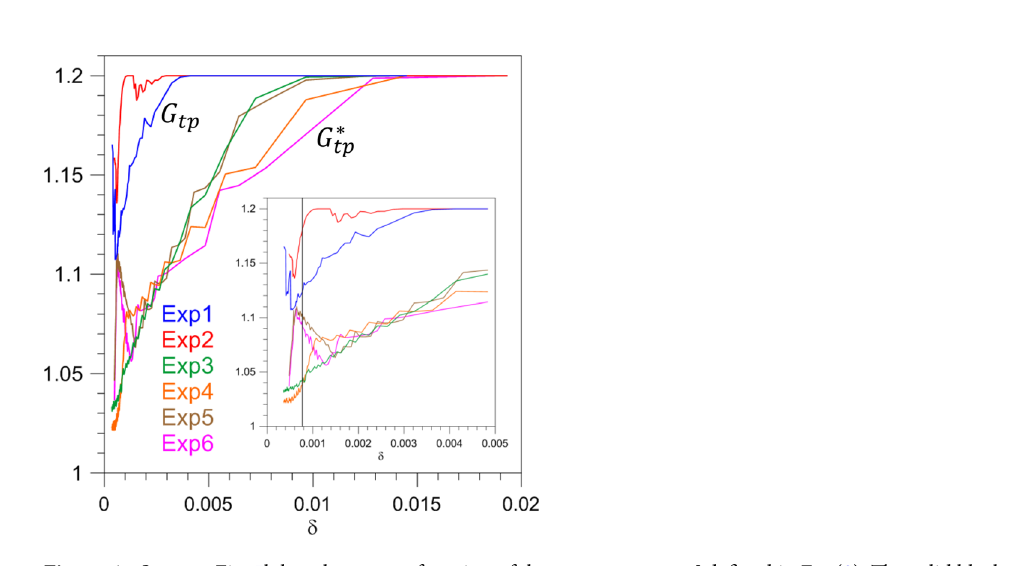
Figure 6. Same as Fig. 5b but shown as a function of the ramp steepness δ defined in Eq. (3). The solid black vertical line in the zoomed inset indicates the ramp steepness δ corresponding to the two ESs of Exp1 (blue line) and Exp2 (red line) shown in Fig.